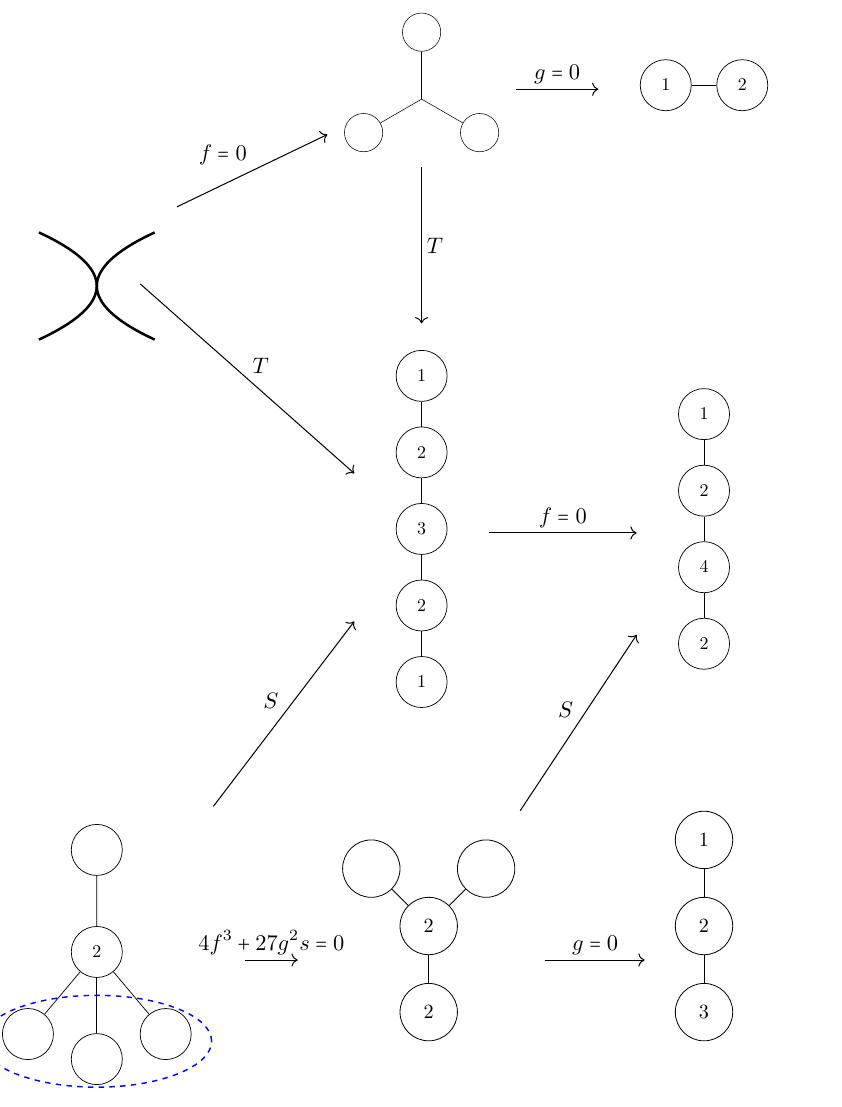
Figure 12 . III + I (cid:3) S 3